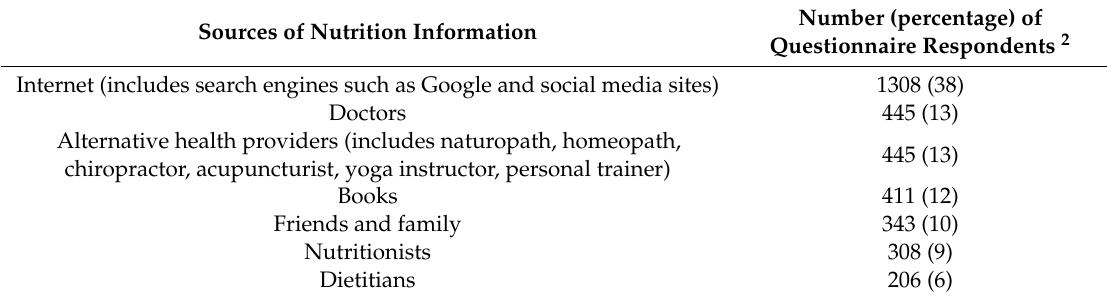
Table 1. Sources of information used to implement anti-inflammatory diets reported by learners 1 .